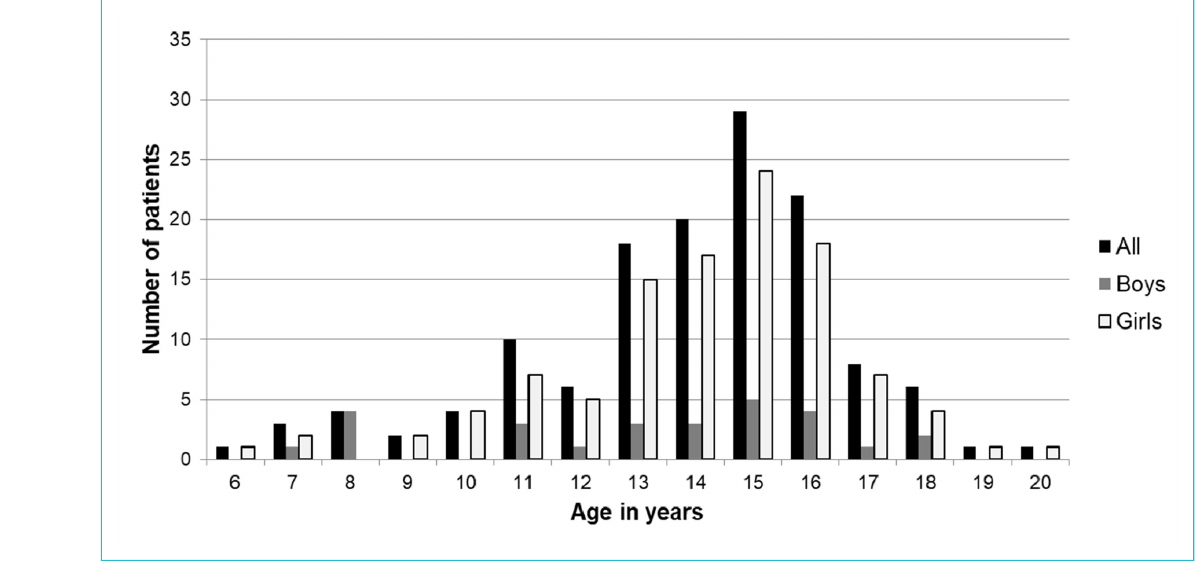
Figure 1: Age distribution of patients in the chronic pain unit; 108 (80%) were female, mean age was 13.95 years (standard deviation 2.66, 95% confidence interval 13.5–14.4), with a range between 6 and 20